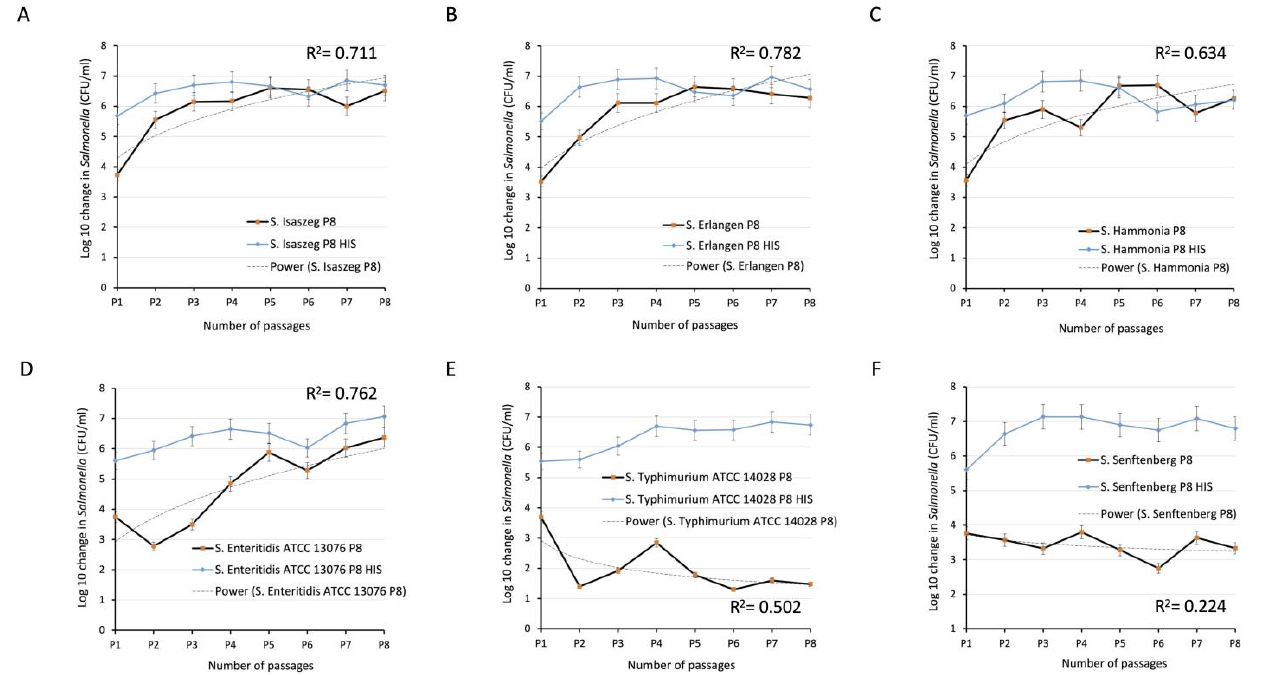
Figure 1. Survival of Salmonella enterica strains during eight passages in 50% human serum from platelet-poor plasma (SPPP). Black/bottom line – survival of Salmonella enterica in 50% SPPP counted as log 10 of colony forming units per ml (CFU/mL −1 ) connected with dashed trendline formula; blue/upper line (control) – survival of bacteria in heat-inactivated (56 °C, 30 min) sera (HISPPP); SS – serum sensitive; SR – serum resistant; ( A ) — S. Isaszeg P8 (SR); ( B ) — S. Erlangen P8 (SR); ( C ) — S. Hammonia P8 (SR); ( D ) — S. Enteritidis ATCC 13076 P8 (SR); ( E ) — S. Typhimurium ATCC 14028 P8 (SS); ( F ) — S. Senftenberg P8 (SS).